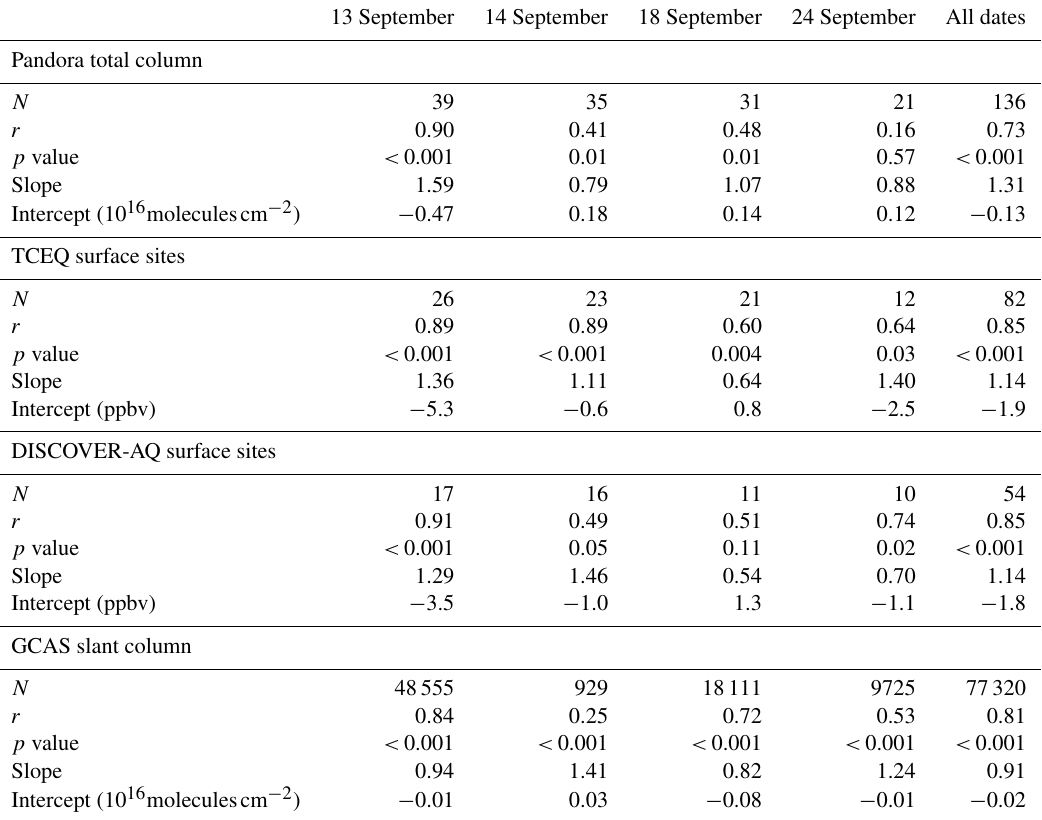
Table 7. Summary of NO 2 comparisons between Pandora total column observations, in situ surface validation mixing ratios and GCAS aircraft slant columns with GeoTASO observations.